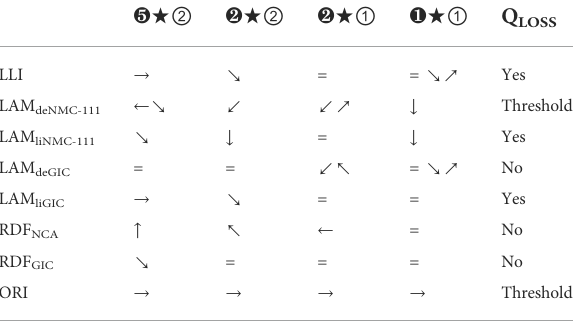
TABLE 1 GIC/NMC 111 summary of peak evolution with degradation in charge. Font size is representative of intensity of changes. ❺ +